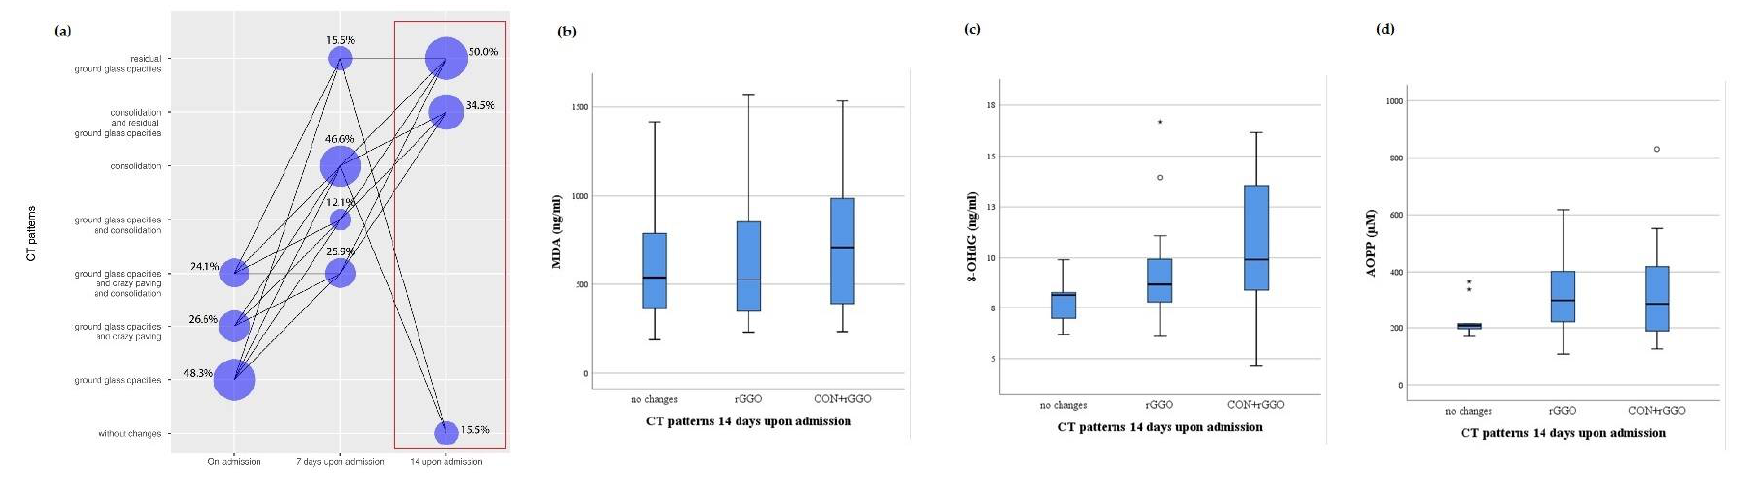
Figure 4. The frequency of CT patterns with their timely progression ( a ) and relation with the levels of MDA ( b ), 8-OHdG ( c ) and AOPP ( d ) in COVID-19 patients 14 days upon admission; CON—consolidation; rGGO—residual ground glass opacities.